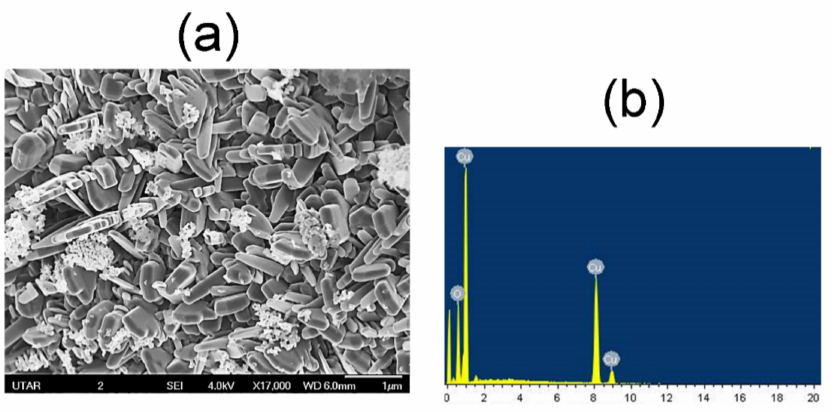
Figure 6. ( a ) FESEM images and ( b ) EDX spectrum of M. calabura derived CuO nanoparticles.